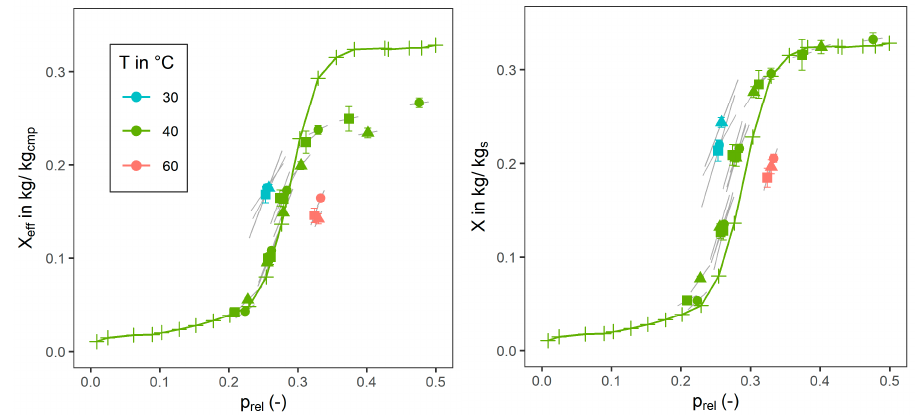
Figure 4. E ff ective loading X e ff and loading X = X e ff / w s,dry over relative pressure measured for Figure 4. Effective loading 𝑋 (cid:2915)(cid:2916)(cid:2916) and loading 𝑋 = 𝑋 (cid:2915)(cid:2916)(cid:2916) /𝑤 (cid:2929),(cid:2914)(cid:2928)(cid:2935) over relative pressure measured for samples Ct_140 ( (cid:78) ), Ct_240 ( (cid:4) ), and Ct_610 ( • ) in comparison with the 40 ◦ C isotherm of the pure samples Ct_140 ( ▲ ), Ct_240 ( ■ ), and Ct_610 ( ● ) in comparison with the 40 °C isotherm of the pure adsorbent powder ( + ), adsorbent content w s,dry determined by uptake correction; grey lines: local adsorbent powder ( + ), adsorbent content 𝑤 (cid:2929),(cid:2914)(cid:2928)(cid:2935) determined by uptake correction; grey lines: local equilibrium slope measured by small volume jumps. equilibrium slope measured by small volume jumps.